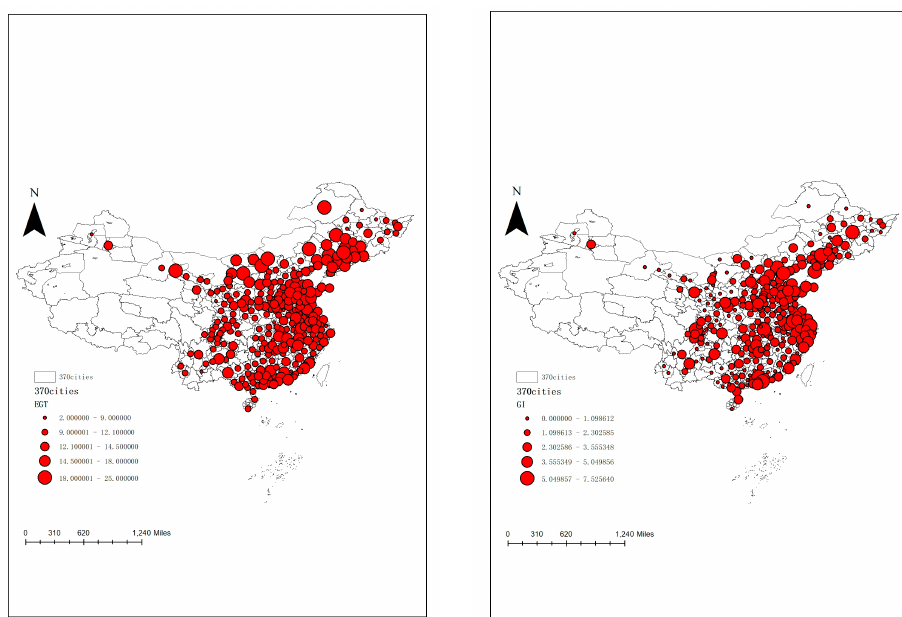
Figure 1. Spatial distribution of EGT and GI in 2006.